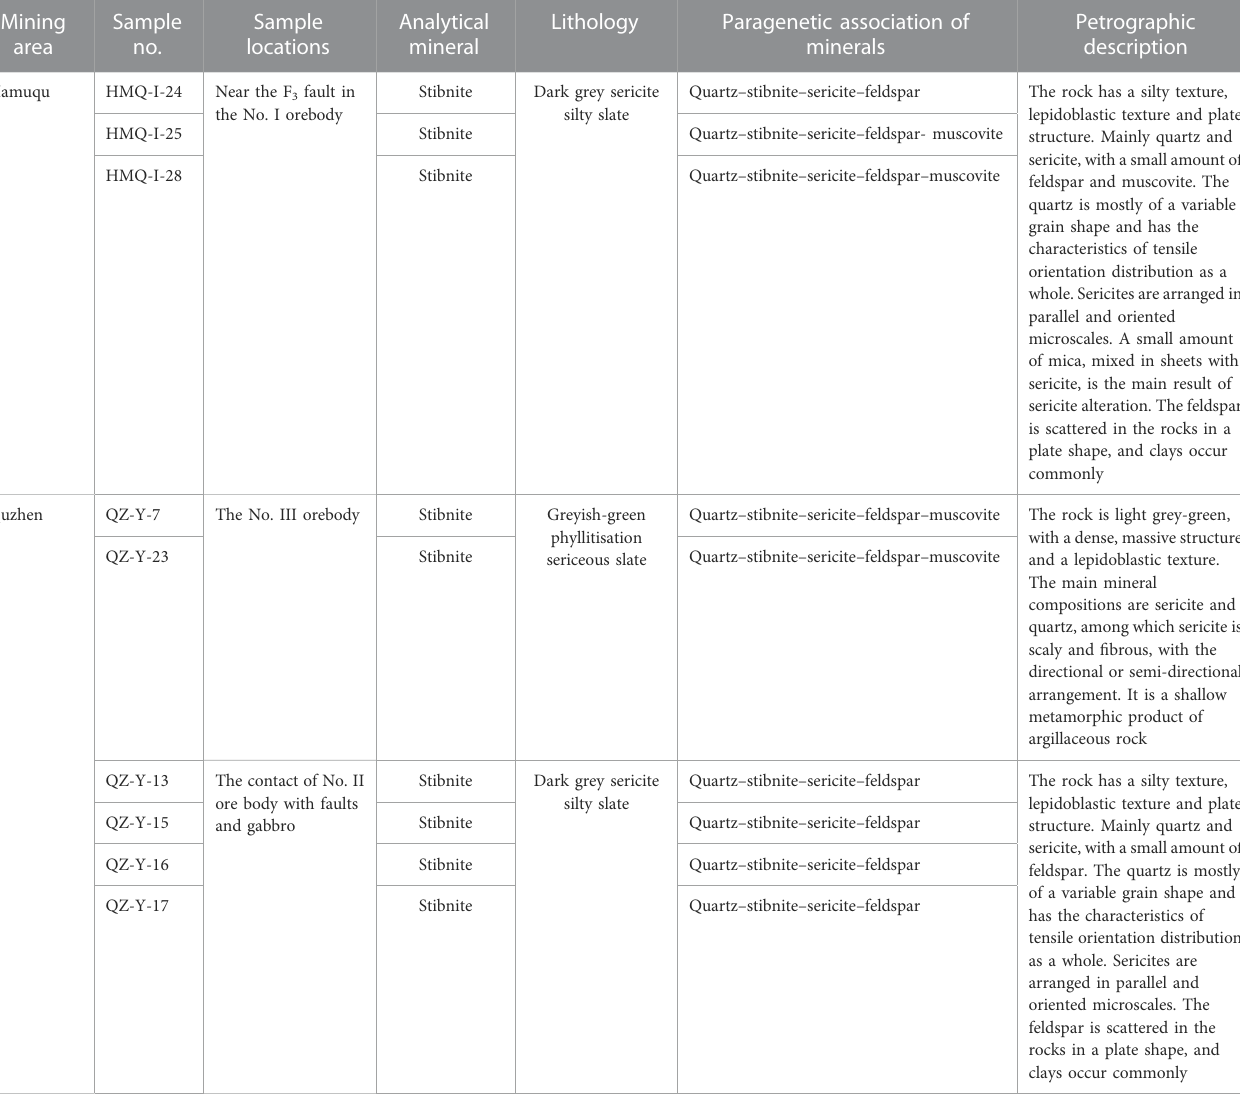
TABLE 1 Location and brief descriptions of the samples used for He – Ar – S isotopes analysis. Mining Sample area